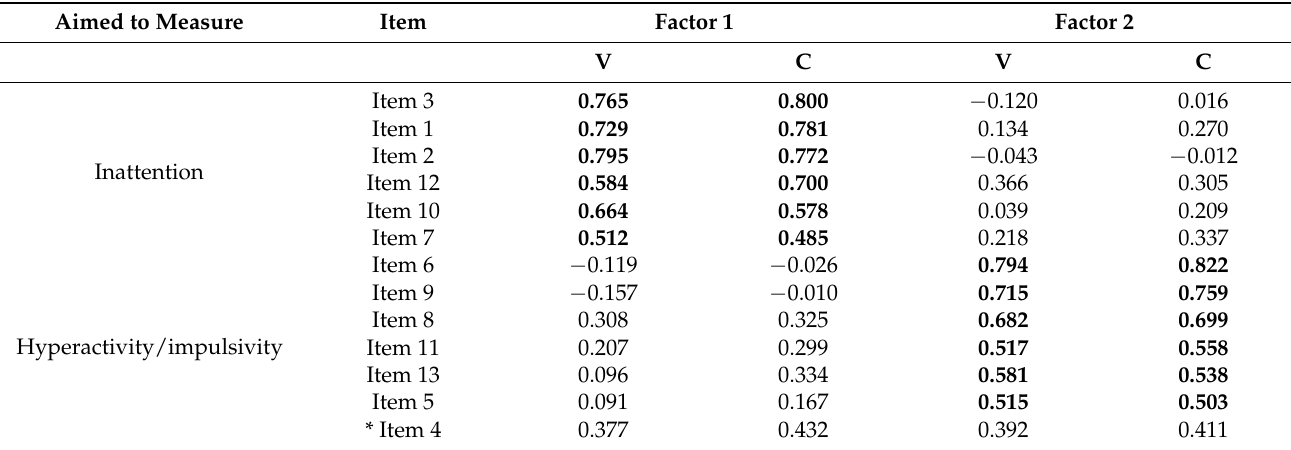
Table 4. Factor loadings of Dog ARS items for the V Dog ARS [14] and the current C Dog ARS samples for Aim 2/Question